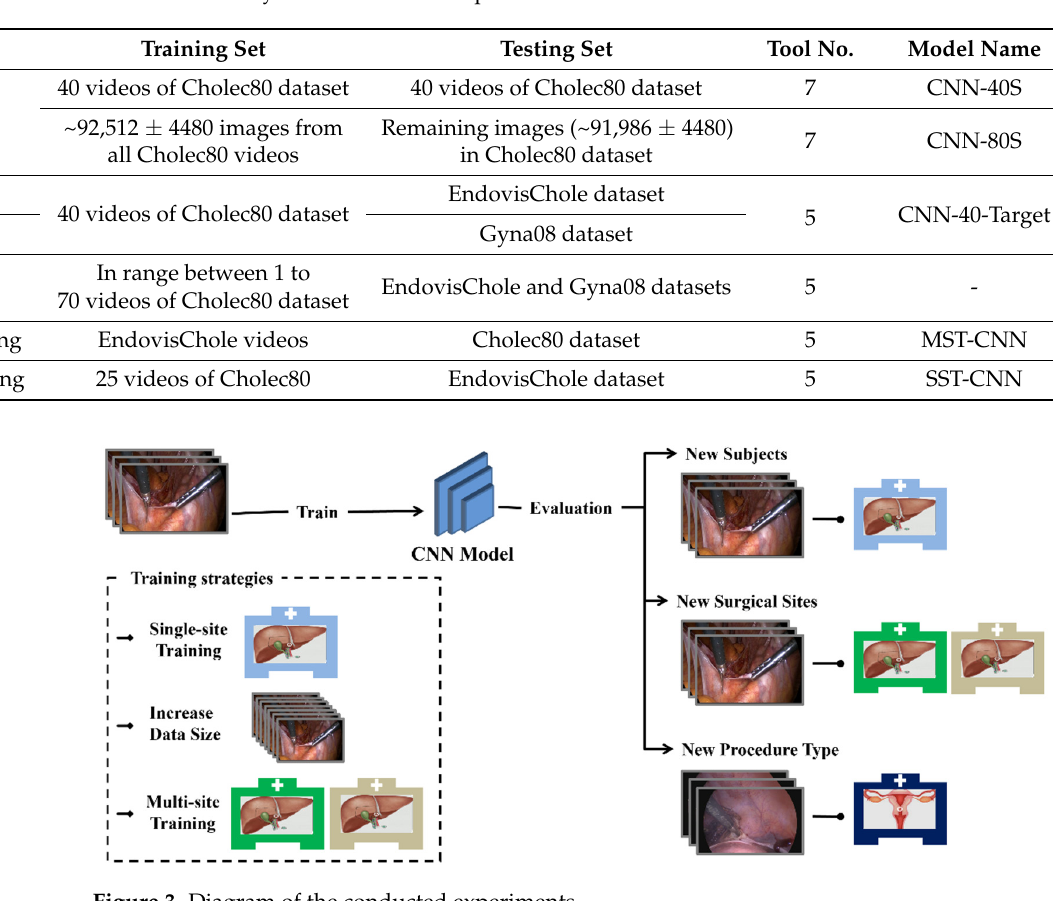
Table 3. Summary of the conducted experiments.